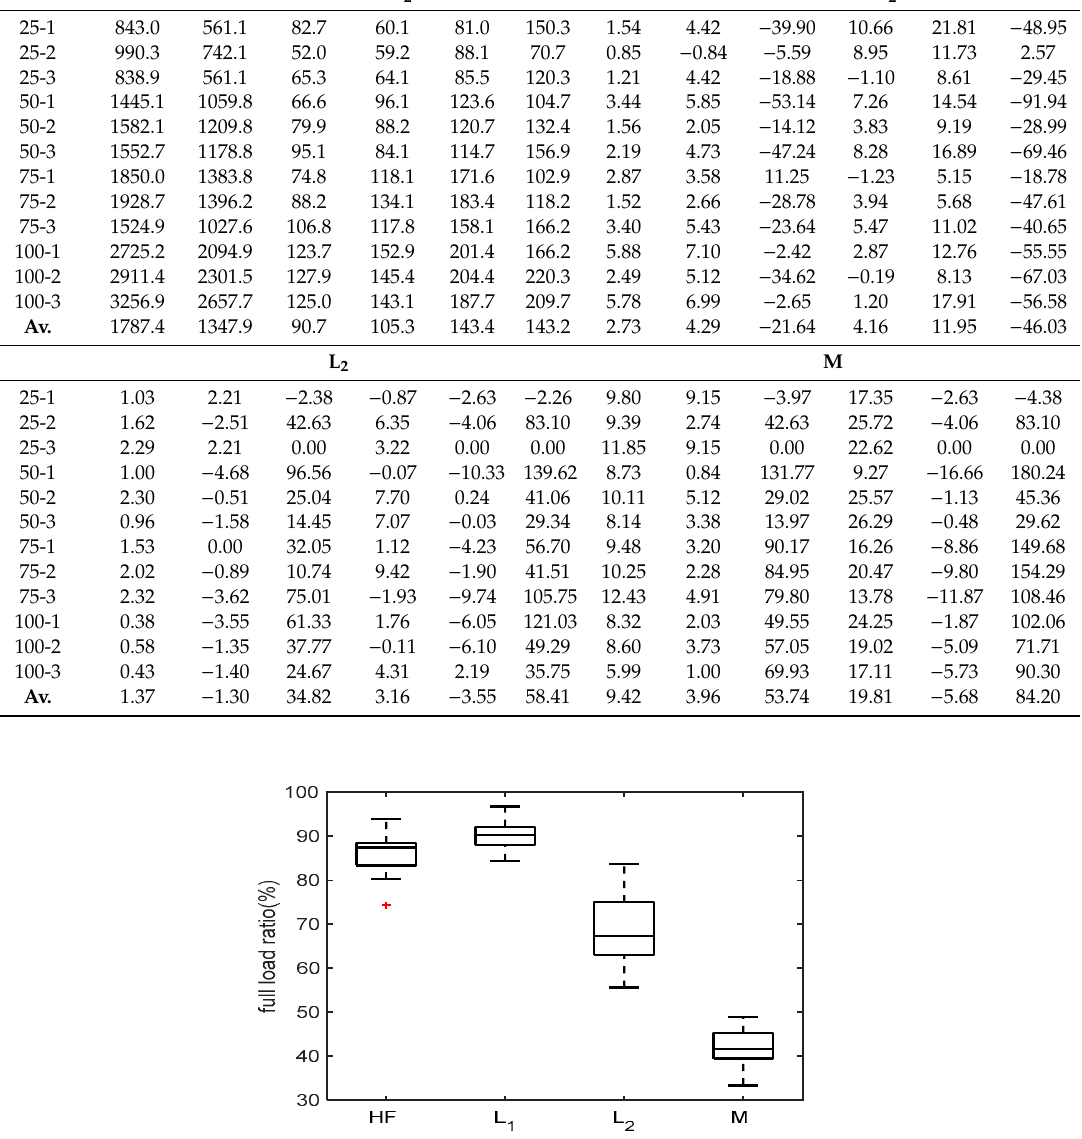
Figure 6. the full load ratios of different fleets. Figure 6. The full load ratios of di